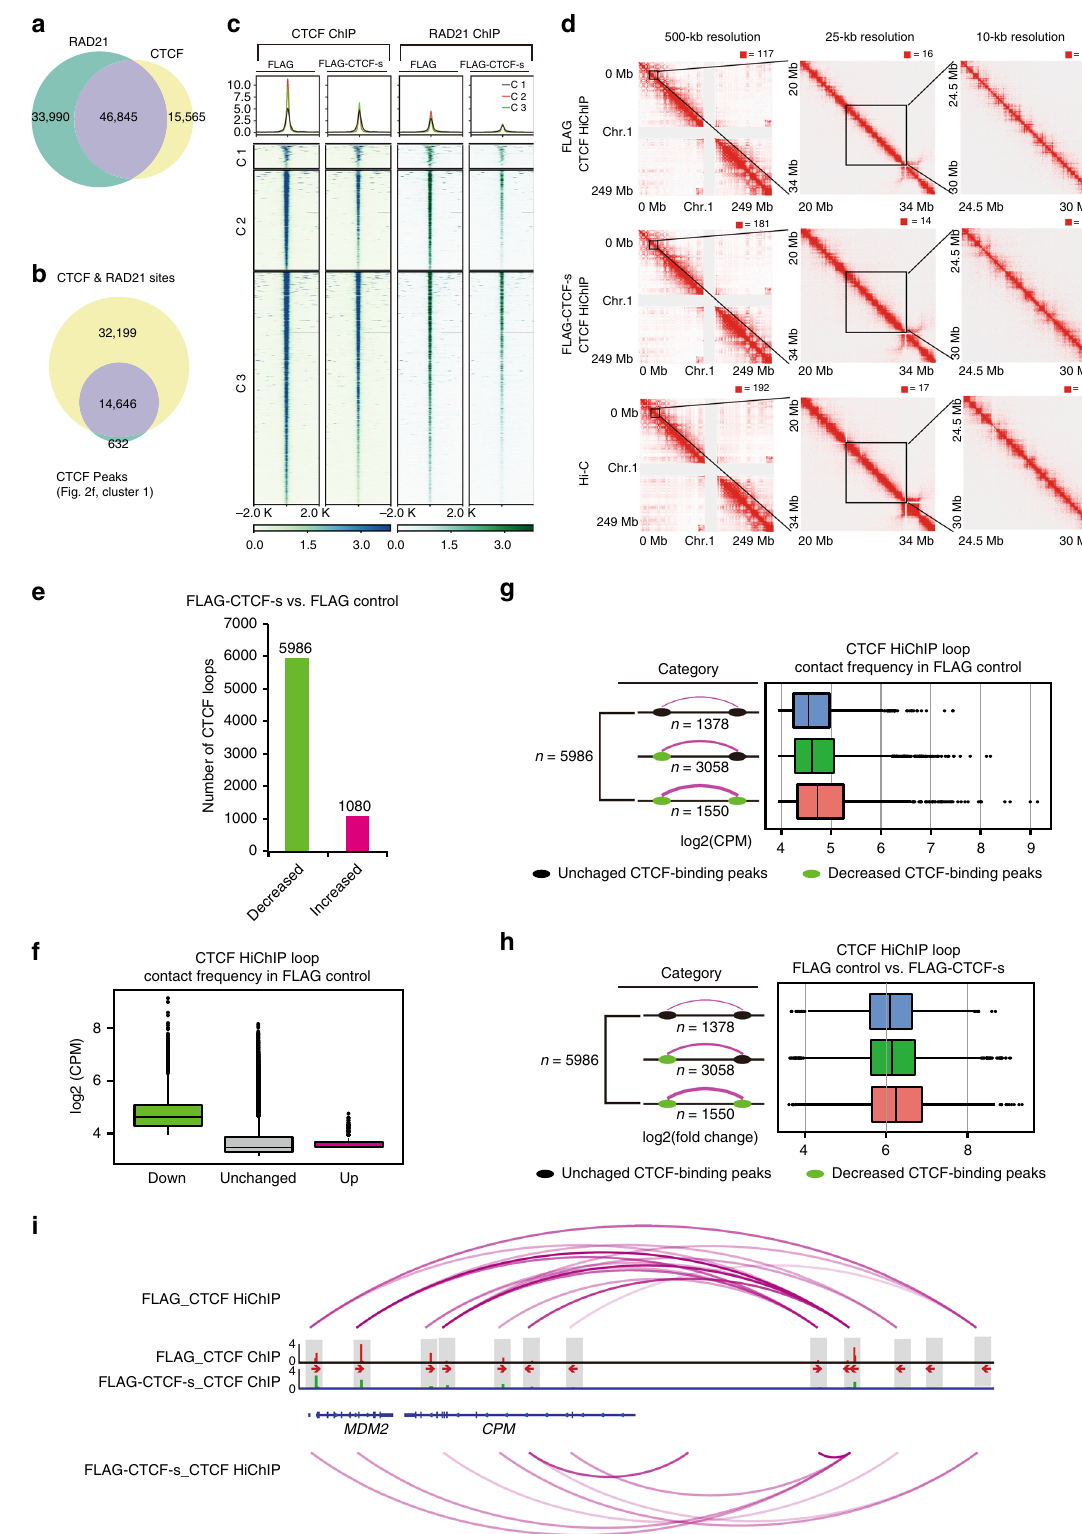
FLAG-CTCF-s vs. FLAG